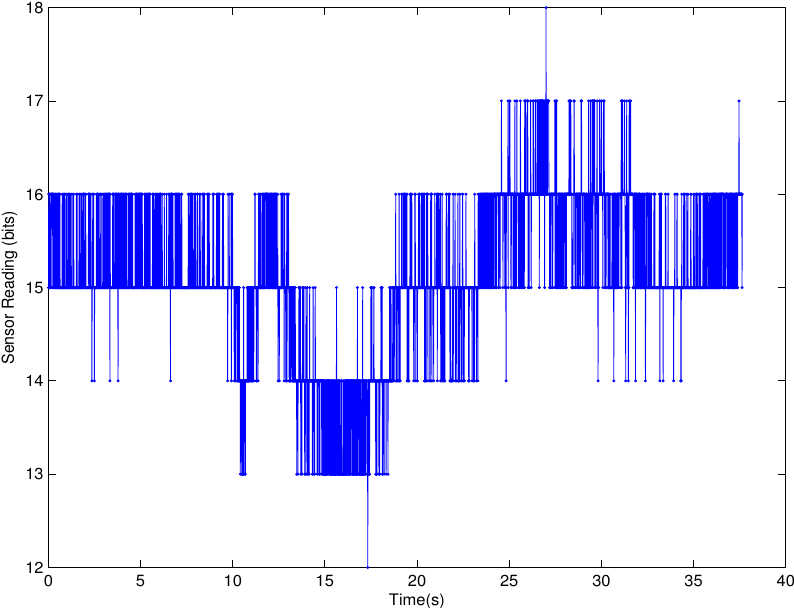
Figure 7. Sensor measurements from test using robotic